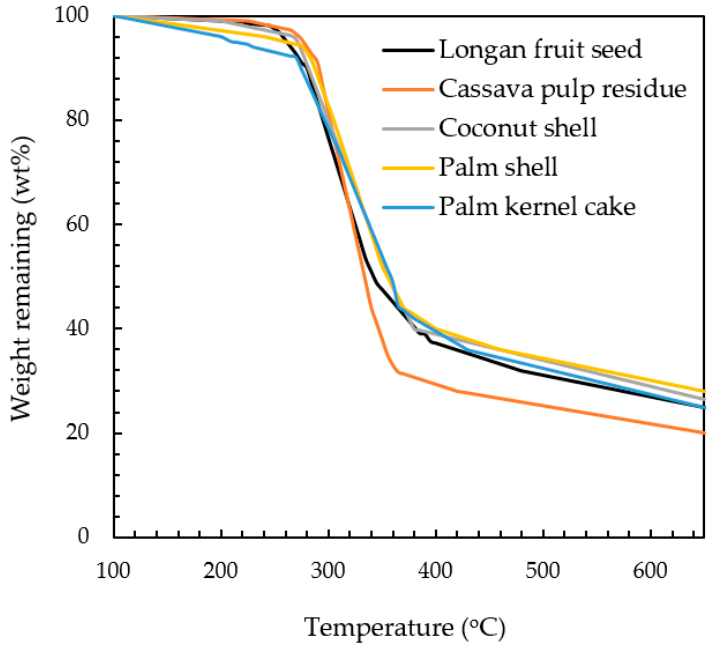
Figure 3. TGA curves of different biomass precursors [25].